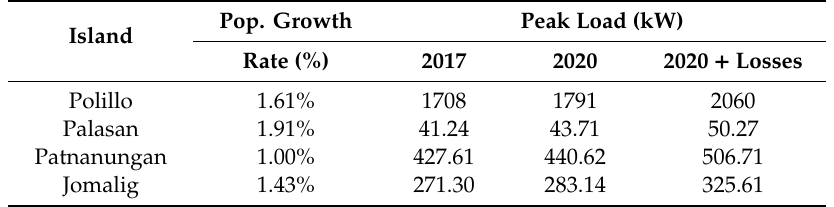
Table A3. Forecasted peak loads of the islands and their respective population growth rates. Island